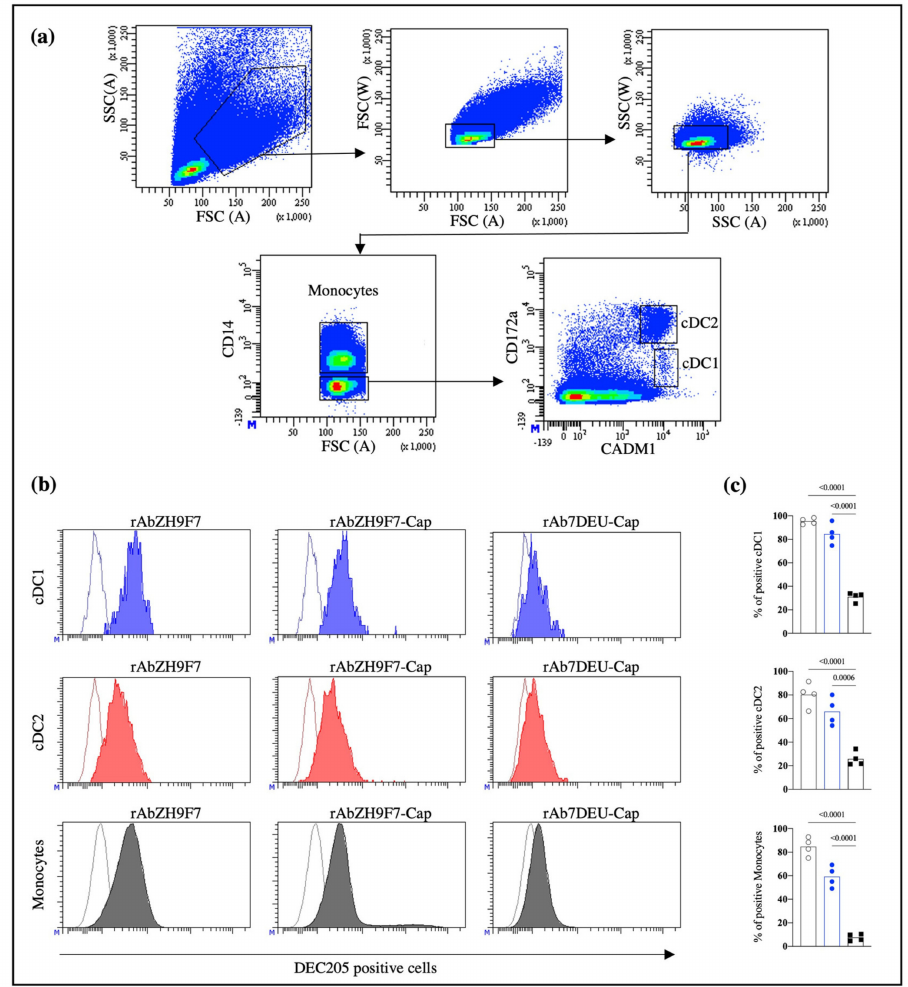
Figure 2. Evaluation of the activity of rAb ZH9F7-Cap to recognize DEC205 + mononuclear cells in peripheral blood (PBMCs) from pigs. ( a ) Strategy for identifying monocytes, cDC1, and cDC2 in blood circulation. ( b ) Identification of DEC205 + cDC1, cDC2, and monocytes after staining with rAb ZH9F7, rAb ZH9F7-Cap, and isotype control rAb 7DEU-Cap. Contour histograms illustrate the FMO, and colored histograms illustrate the expression of DEC205 on cDC1 (blue), cDC2 (red), and monocytes (gray). Histograms represent the results of one of four animals. ( c ) Graphic analysis of the percentages of positive cDC1 (top), cDC2 (middle), and monocyte (bottom) cells. rAb ZH9F7 (gray); rAb ZH9F7-Cap (blue); Isotype control rAb 7DEU-Cap (black). One-way ANOVA and the Tukey–Kramer test for multiple comparisons of means were performed ( p < 0.05). p -values denote statistically significant differences in the means of the different